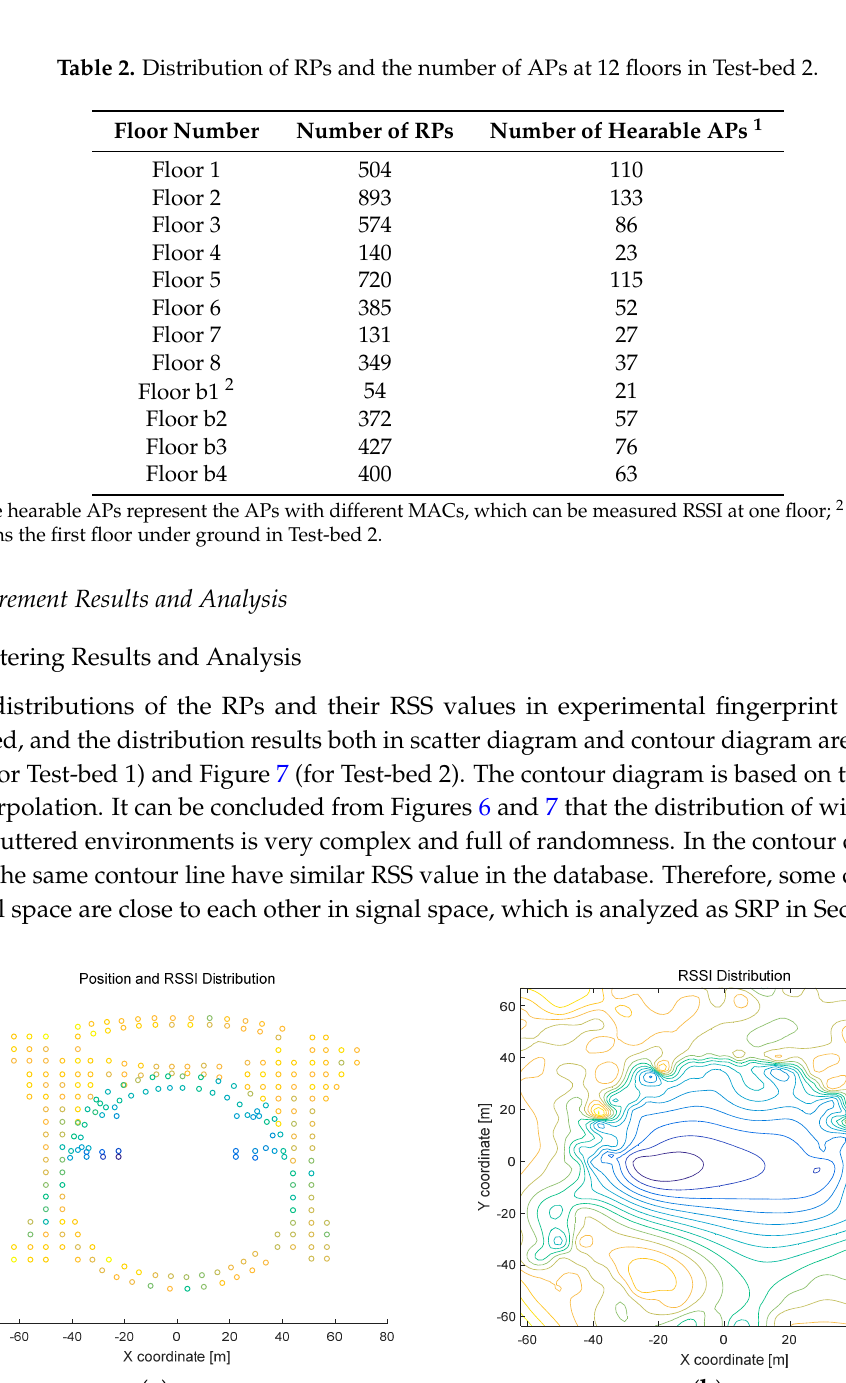
( a ) ( b ) ( c ) ( d ) Figure 7. Reference points’ RSSI distribution in Test-bed 2: ( a ) RSSI distribution in the first floor of Test-bed 2 in scatter diagram; ( b ) RSSI distribution in the first floor of Test-bed 2 in contour map; ( c ) RSSI distribution in the second floor of Test-bed 2 in scatter diagram; and ( d ) RSSI distribution in the second floor of Test-bed 2 in contour map. Clustering comparison is conducted utilizing the methos of K-means and SEC. K-means is a classical and RSS-based clustering algorithm, and SEC is a novel and coordinate-based clustering algorithm proposed in this paper. Clustering results are shown in Figures 8 and 9 for Test-beds 1 and 2, respectively. It can be concluded that the clustering results using K-means is dispersive in physical